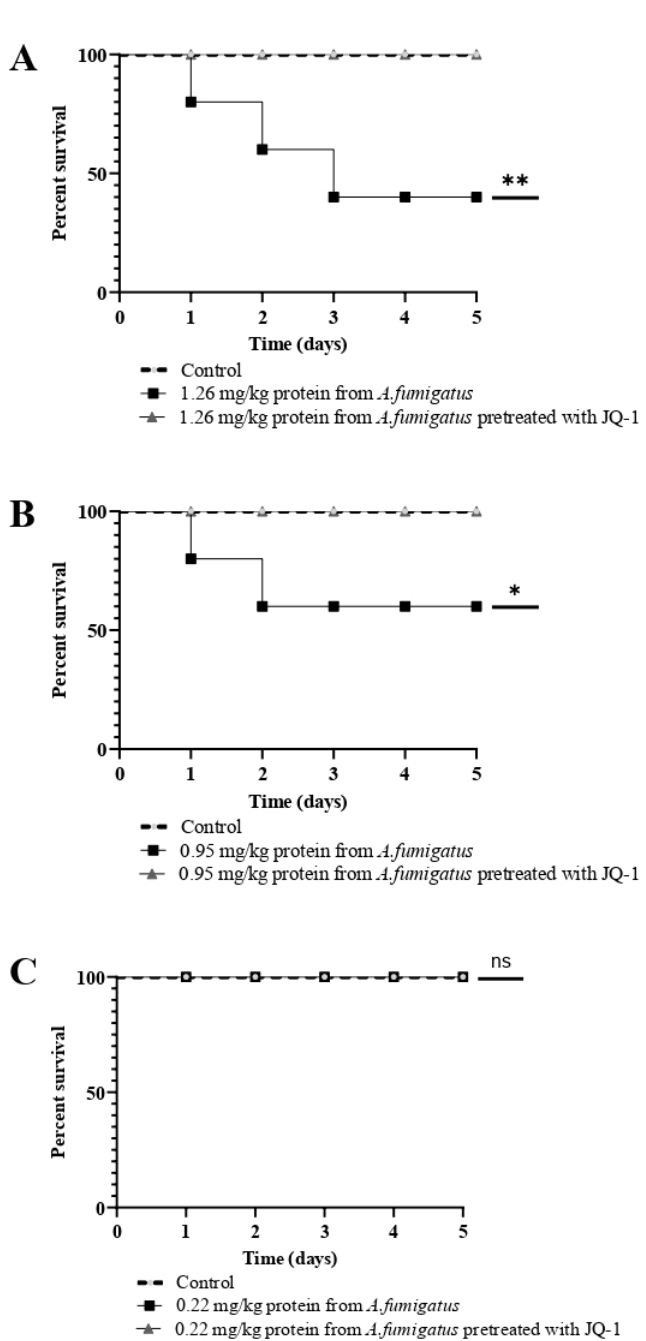
Figure 10. Effect of extracellular proteins obtained from A. fumigatus treated or not with 100 µ M of JQ1. Proteins concentration 1.26 mg/kg larvae ( A ), proteins concentration 0.95 mg/kg larvae ( B ), proteins concentration 0.22 mg/kg larvae ( C ). G. mellonella survival curves (n = 15/strain). Larvae were checked daily for 5 days post-infection. Statistical significance compared to control was assessed by the Kaplan–Meier followed by Mantel–Cox log-rank test. Three experiments on different dates were performed. * p < 0.05 compared to the conidia from A. fumigatus ; ** p < 0.01 compared to the conidia from A. fumigatus . The activity of extracellular proteins obtained from A. fumigatus pretreated or not with JQ1 on the larvae melanization was evaluated. Proteins ranging from 1.26 mg/kg